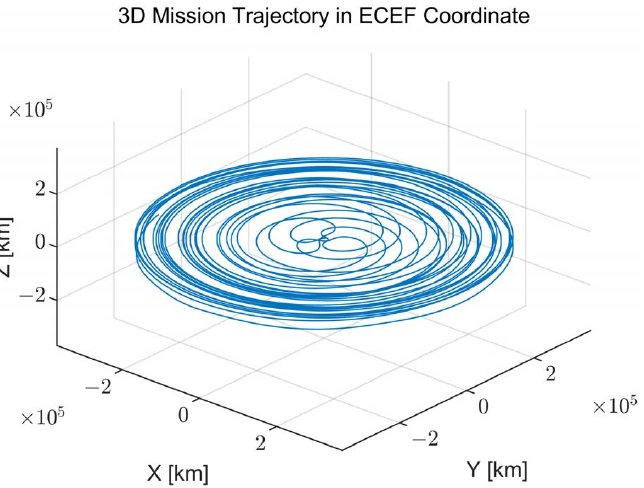
Figure 1. Overall Moon exploration mission trajectory in the earth-centered, earth-fixed (ECEF) coordinate.